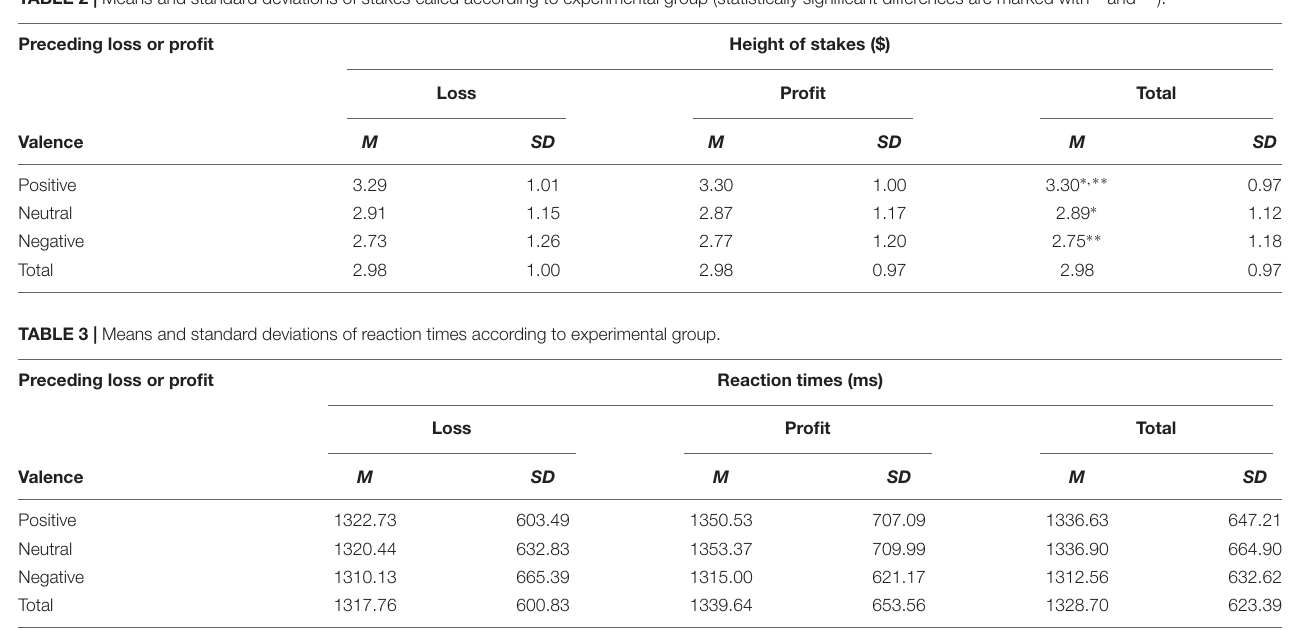
TABLE 2 | Means and standard deviations of stakes called according to experimental group (statistically significant differences are marked with ∗ and ∗∗ ).